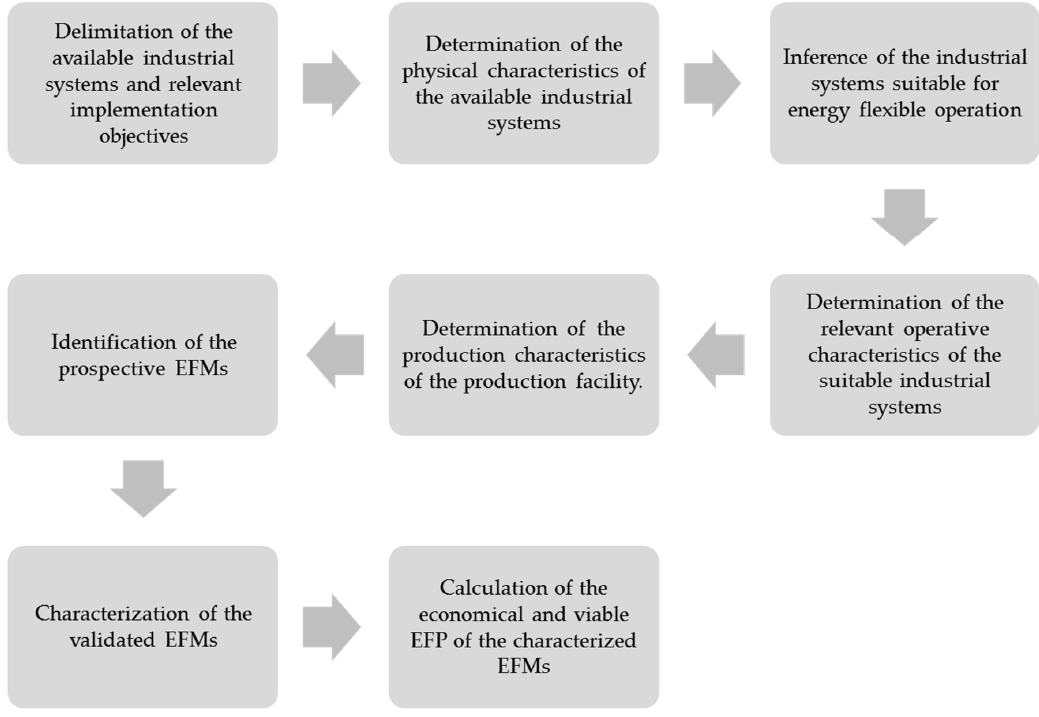
Figure 4. Steps to identify and characterize EFMs.